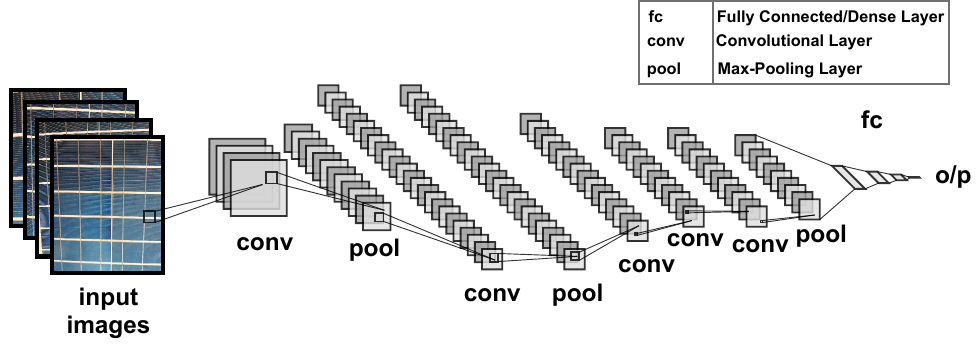
Figure 8. SolNet